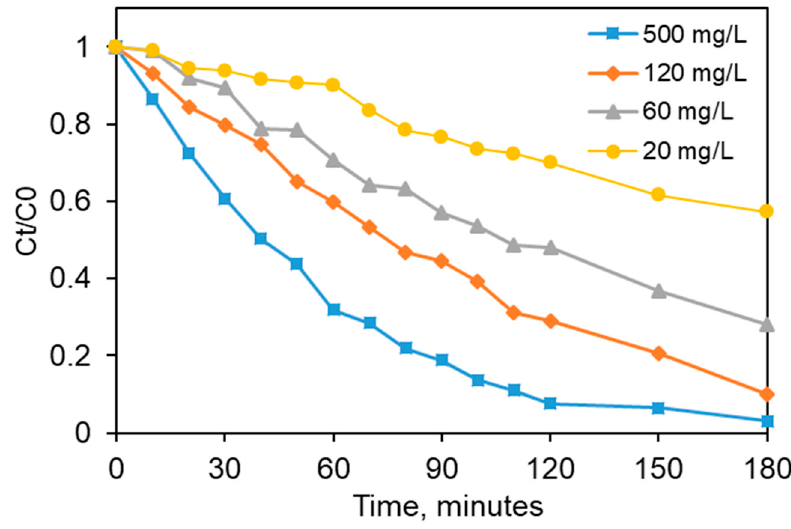
Figure 11. E ff ects of the catalyst load on the photodegradation of clofibric acid (pollutant concentration Figure 11. Effects of the catalyst load on the photodegradation of clofibric acid (pollutant 10 mg / L, stirring rate 450 rpm, natural solution pH, UV-A concentration 10 mg/L, stirring rate 450 rpm, natural solution pH, UV-A irradiation).